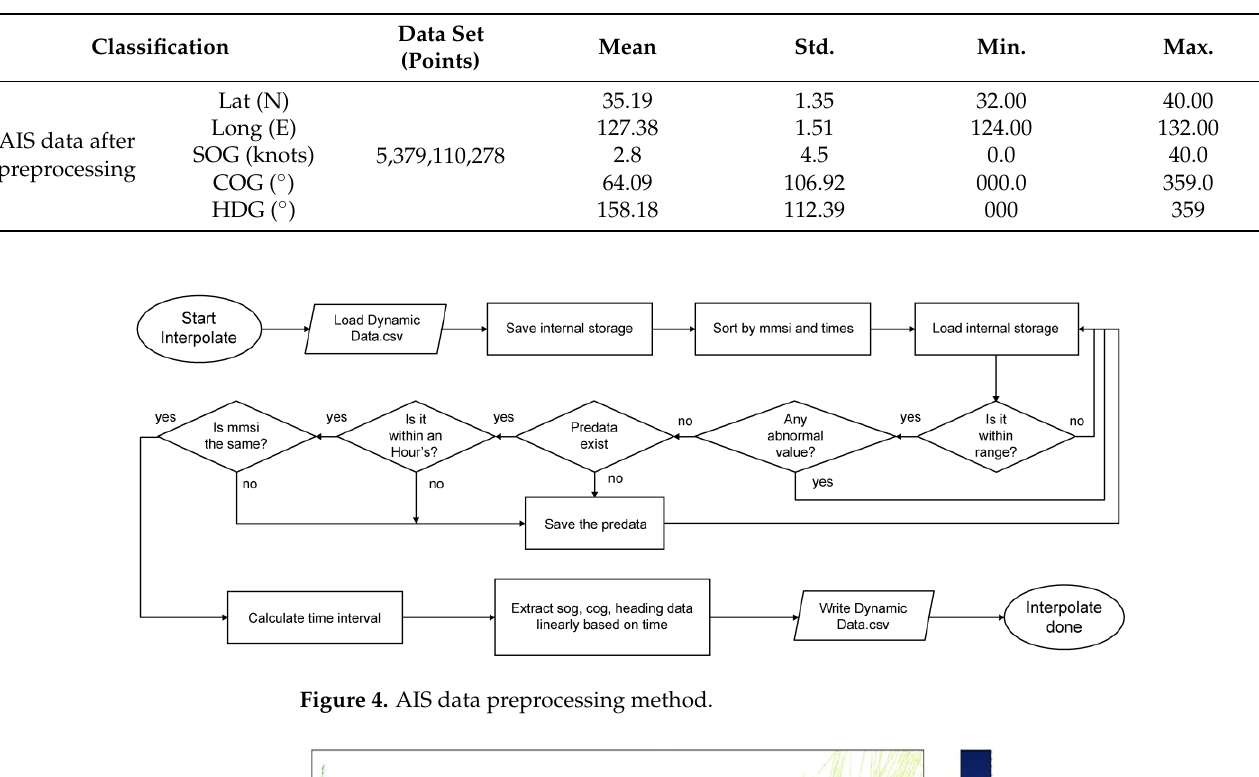
Table 4. Statistical analysis results of AIS data after preprocessing.